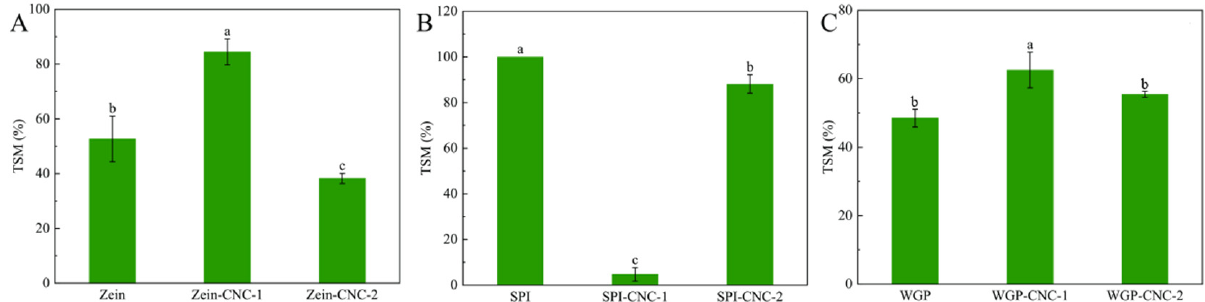
Figure 4. ( A – C ) Total soluble matter of the Zein/SPI/WGP-based films. Different letters (a–c) indicated significant differences ( p < 0.05).